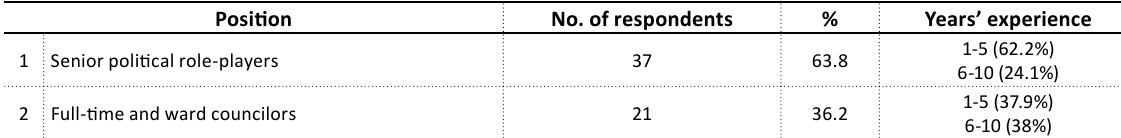
Table 3. Biographical profile of female councilors (target group 1) Position